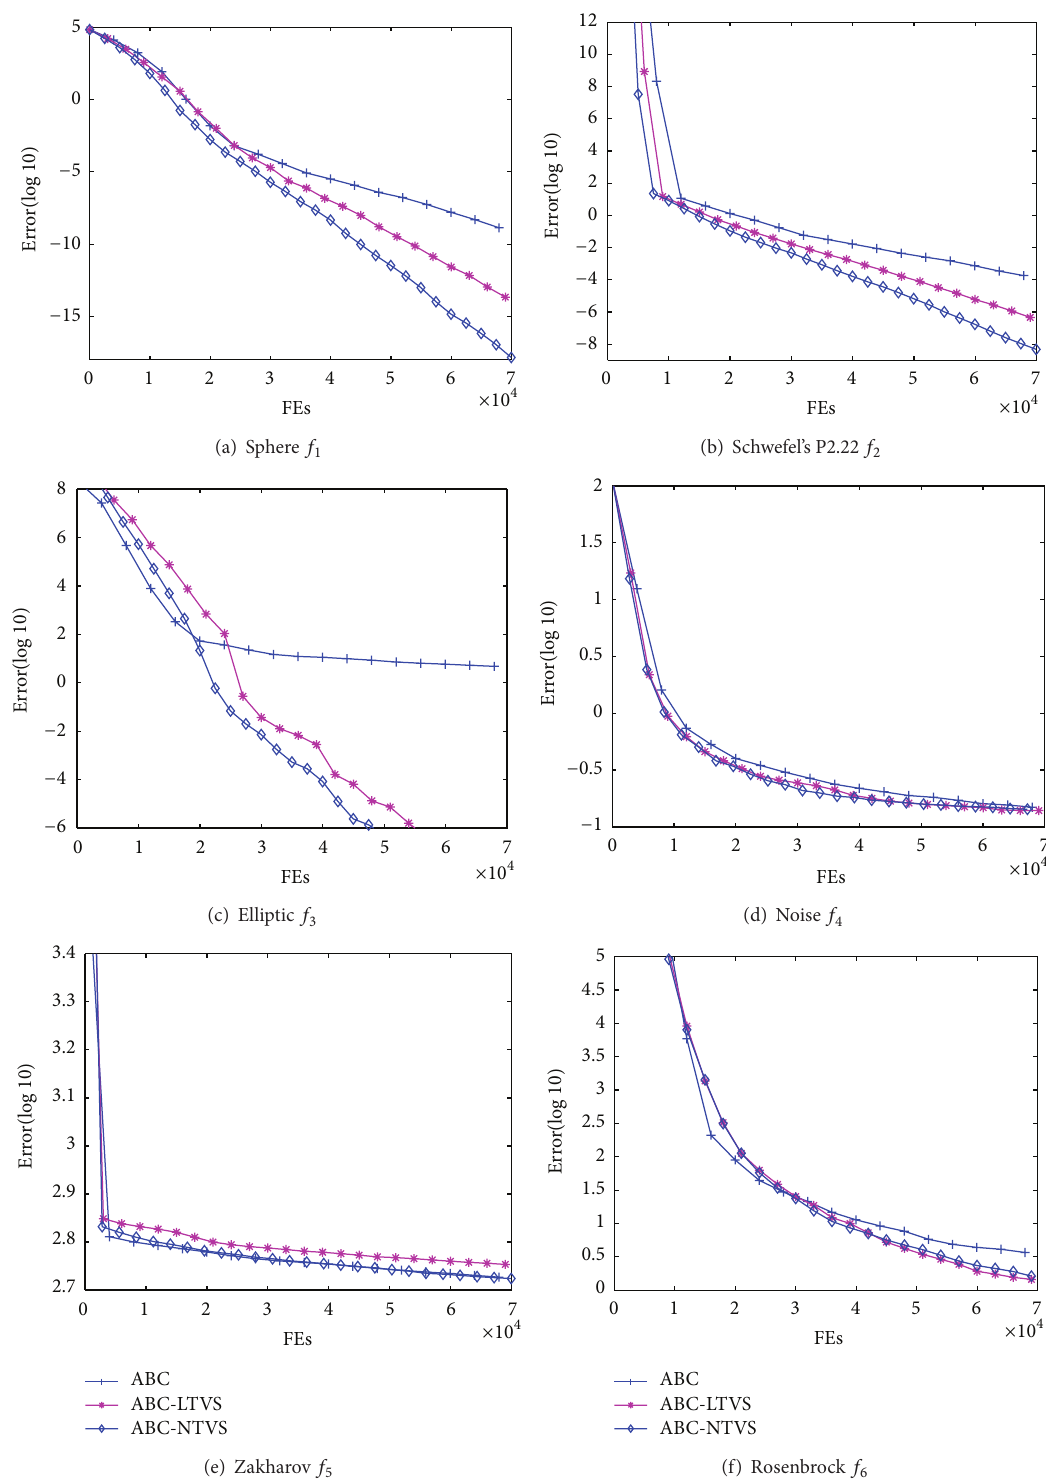
Figure 4: Convergence curves of ABC variants solving unimodal functions 𝑓 1 – 𝑓 5 and multimodal function Rosenbrock 𝑓 6